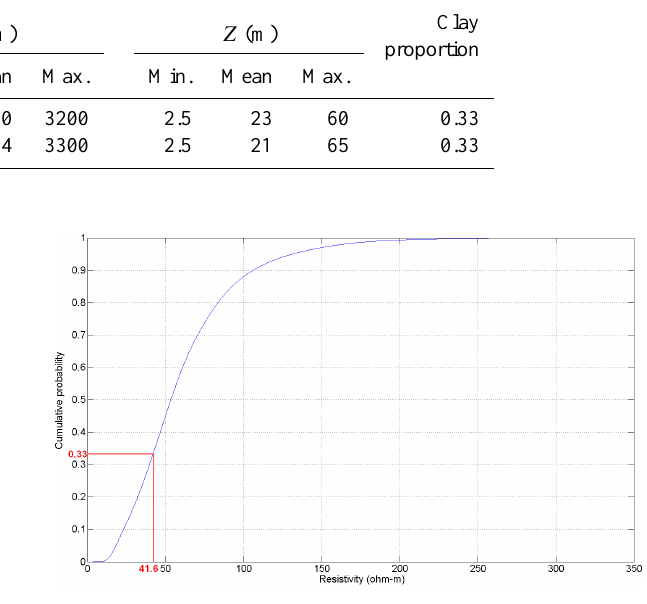
1 Figure 6: The cumulative distribution function (CDF) of SkyTEM data. Resistivity of 41.6 ohm-2 Figure 6. The CDF of SkyTEM data. Resistivity of 41.6 (cid:127) · m cor- m corresponds to a proportion of 0.33, which is the proportion of Quaternary clay according to 3 responds to a proportion of 0.33, which is the proportion of Quater- borehole data. 4 nary clay according to borehole